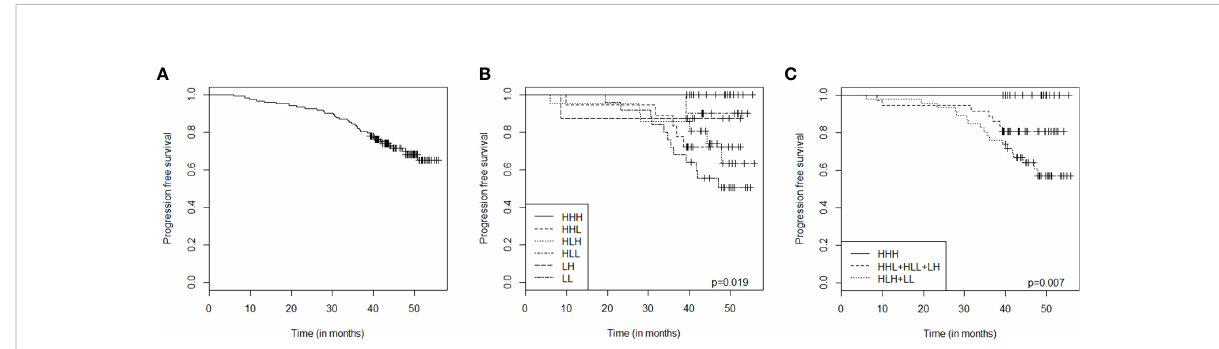
FIGURE 3 Progression free survival (PFS) in the total cohort according to the fi ve-miRNA decision tree signature. PFS in the total cohort (A) , according to the six different groups of signatures identi fi ed in the miRNA decision tree (B) , or with combined miRNA signature groups (C) . PFS, Progression free survival; HHH, group of patients with miR-125b high, miR-15b high and miR-181c high; HHL, group of patients with miR-125b high, miR- 15b high and miR-181c low; HLH, group of patients with miR-125b high, miR-15b low and miR-412 high; HLL, group of patients with miR-125b high, miR-15b low and miR-412 low; LH, group of patients with miR-125b low and miR-193b high; LL, group of patients with miR-125b low and miR-193b low; HHL+HLH+HLL+LH, consolidation of HHL-, HLH-, HLL-, and